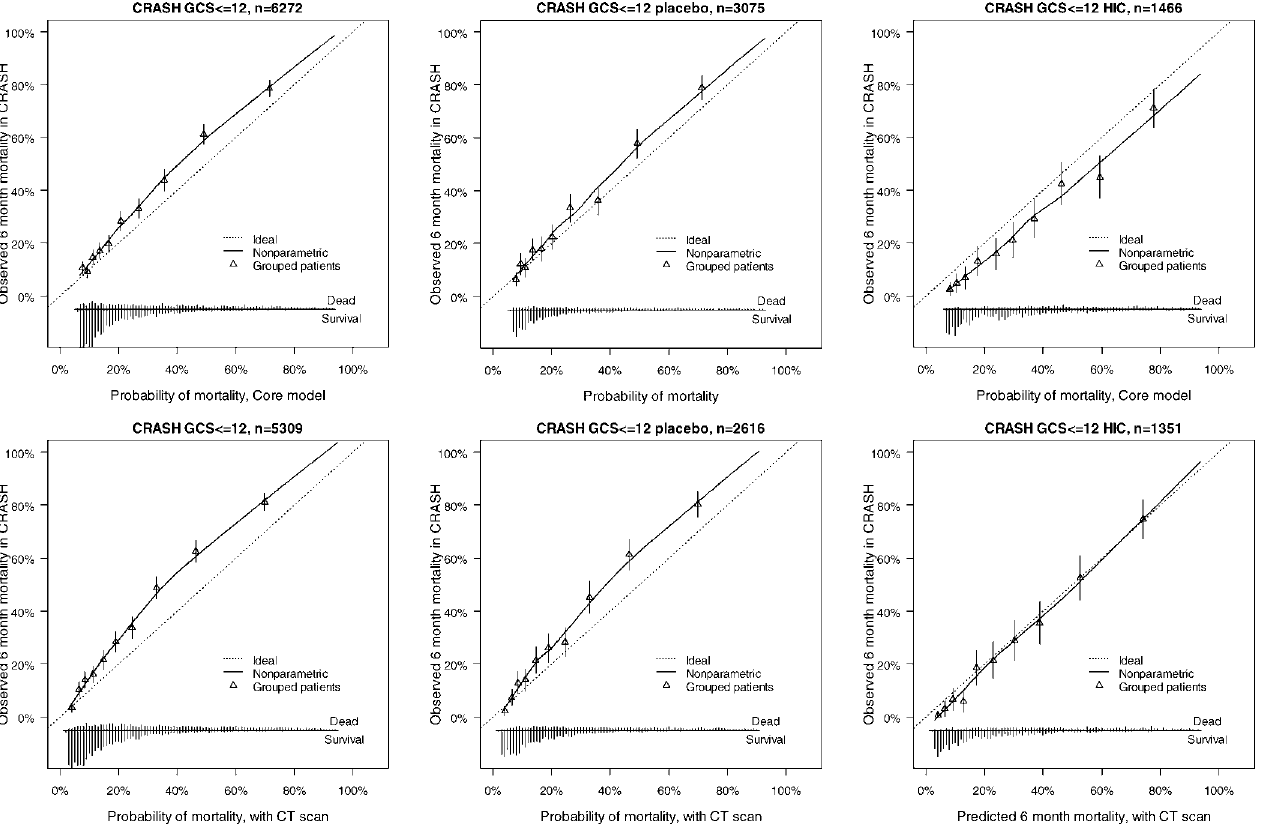
Figure 4. External Validity for the Core and Core þ CT Model Characteristics for Prediction of Mortality in the CRASH Trial The distribution of predicted probabilities is shown at the bottom of the graphs, by 6-mo mortality. The triangles indicate the observed frequencies by decile of predicted